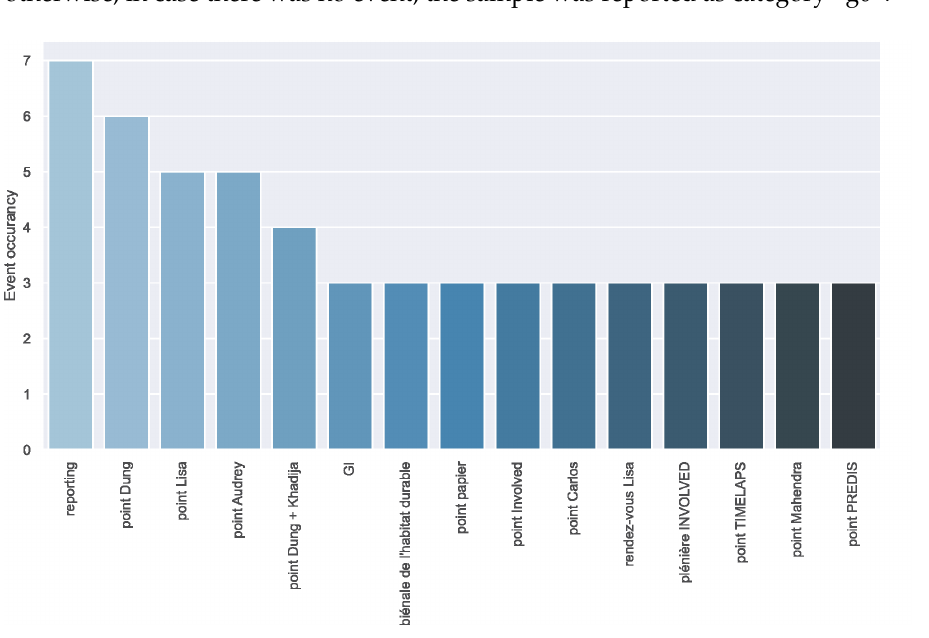
Figure 5. The most frequent office events and their